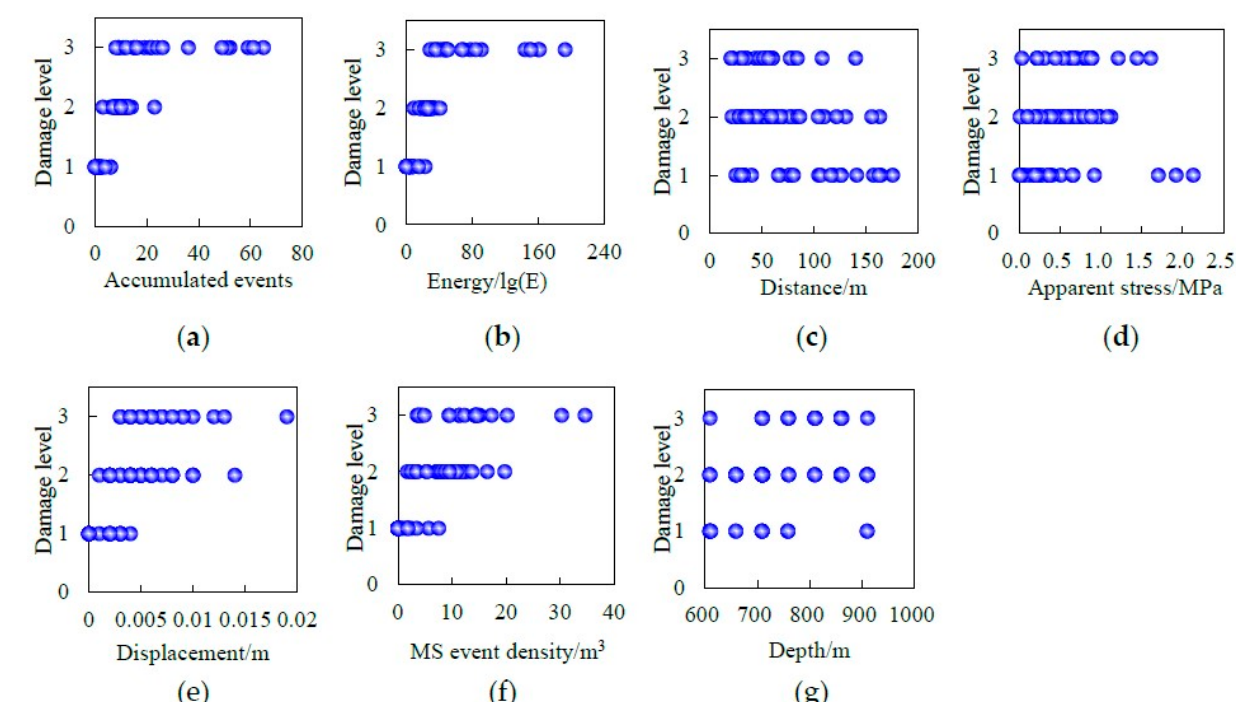
Figure 7. Distribution of evaluation indexes across the damage levels. ( a ) accumulated events; ( b ) energy; ( c ) distance; ( d ) apparent stress; ( e ) displacement; ( f ) MS event density; ( g ) depth. Numbers along the y -axis (1, 2, and 3) represent the damage levels (no damage, slight damage, and moderate damage, respectively).